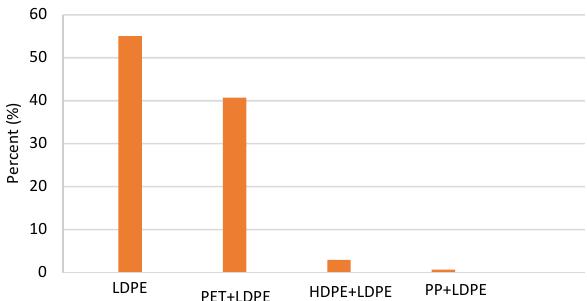
Fig. 2: The proportion of different types of plastics discarded from households in Watamu 42 .